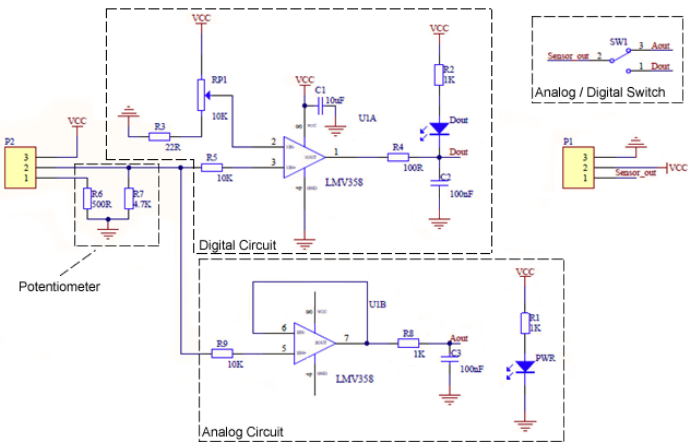
Figure 3. DF Robot Gravity analogue turbidity sensor electronics schematic.